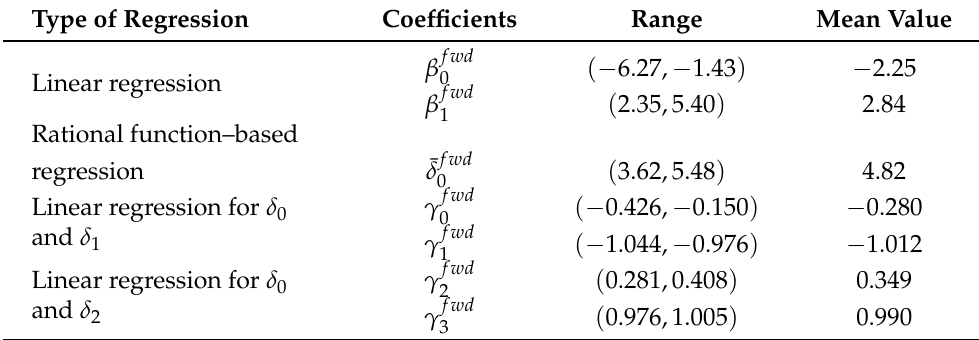
Table 2. Summary of coefficients for 12 groups of randomly selected map